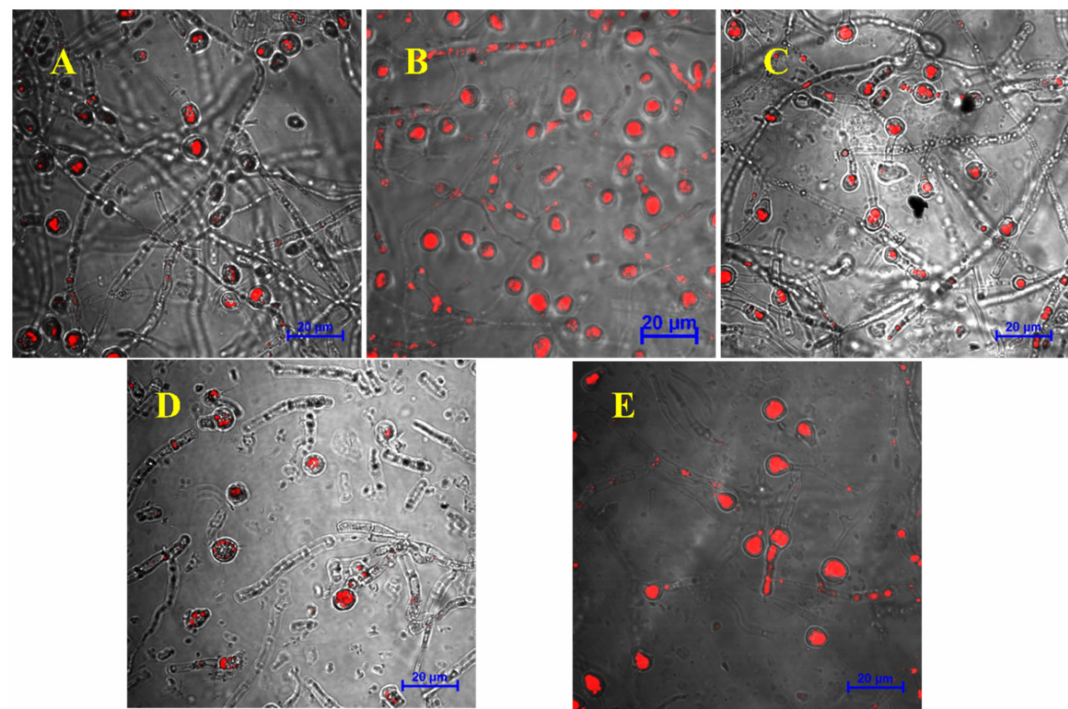
Figure 4. Images of chlamydospores produced by adding different exogenous regulators, as observed under a confocal microscope: ( A ) control group, ( B ) mannitol, ( C ) glycine betaine, ( D ) N-A-G, and ( E ) trehalose. The scale of the image is 20 µ m.